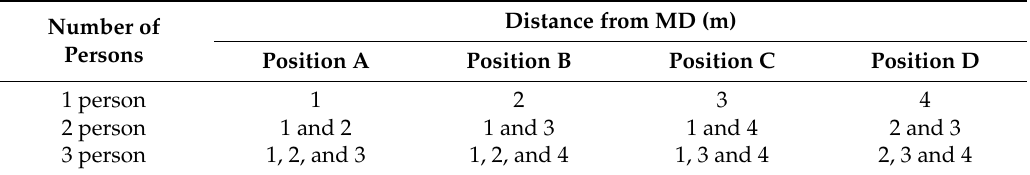
Table 4. People position in experiments to define PPE influence distance.